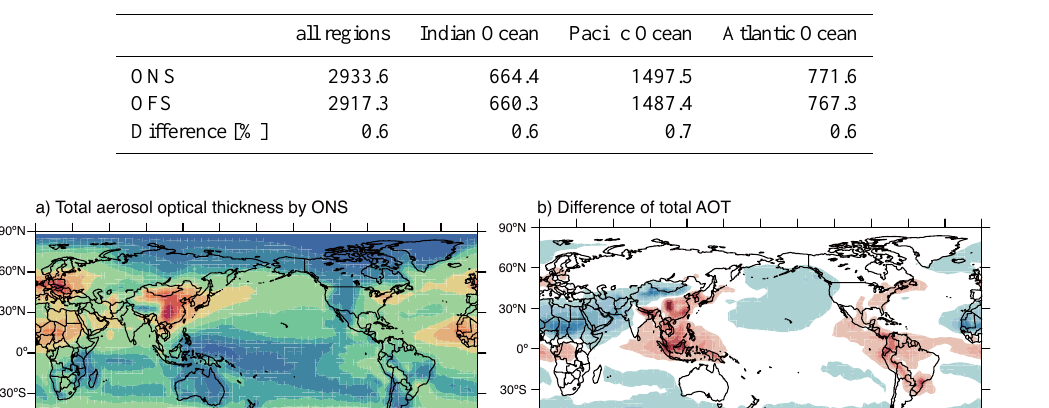
Asia, and the eastern coast of North America) is dominated by sulfate aerosol. On the other hand, carbonaceous aerosol contributes to overestimations over biomass burning sources (i.e. Central Africa, Southeast Asia, and Central and South America). The relatively large positive bias ( ∼ 0.09 of the total AOT) around southwestern China and Southeast